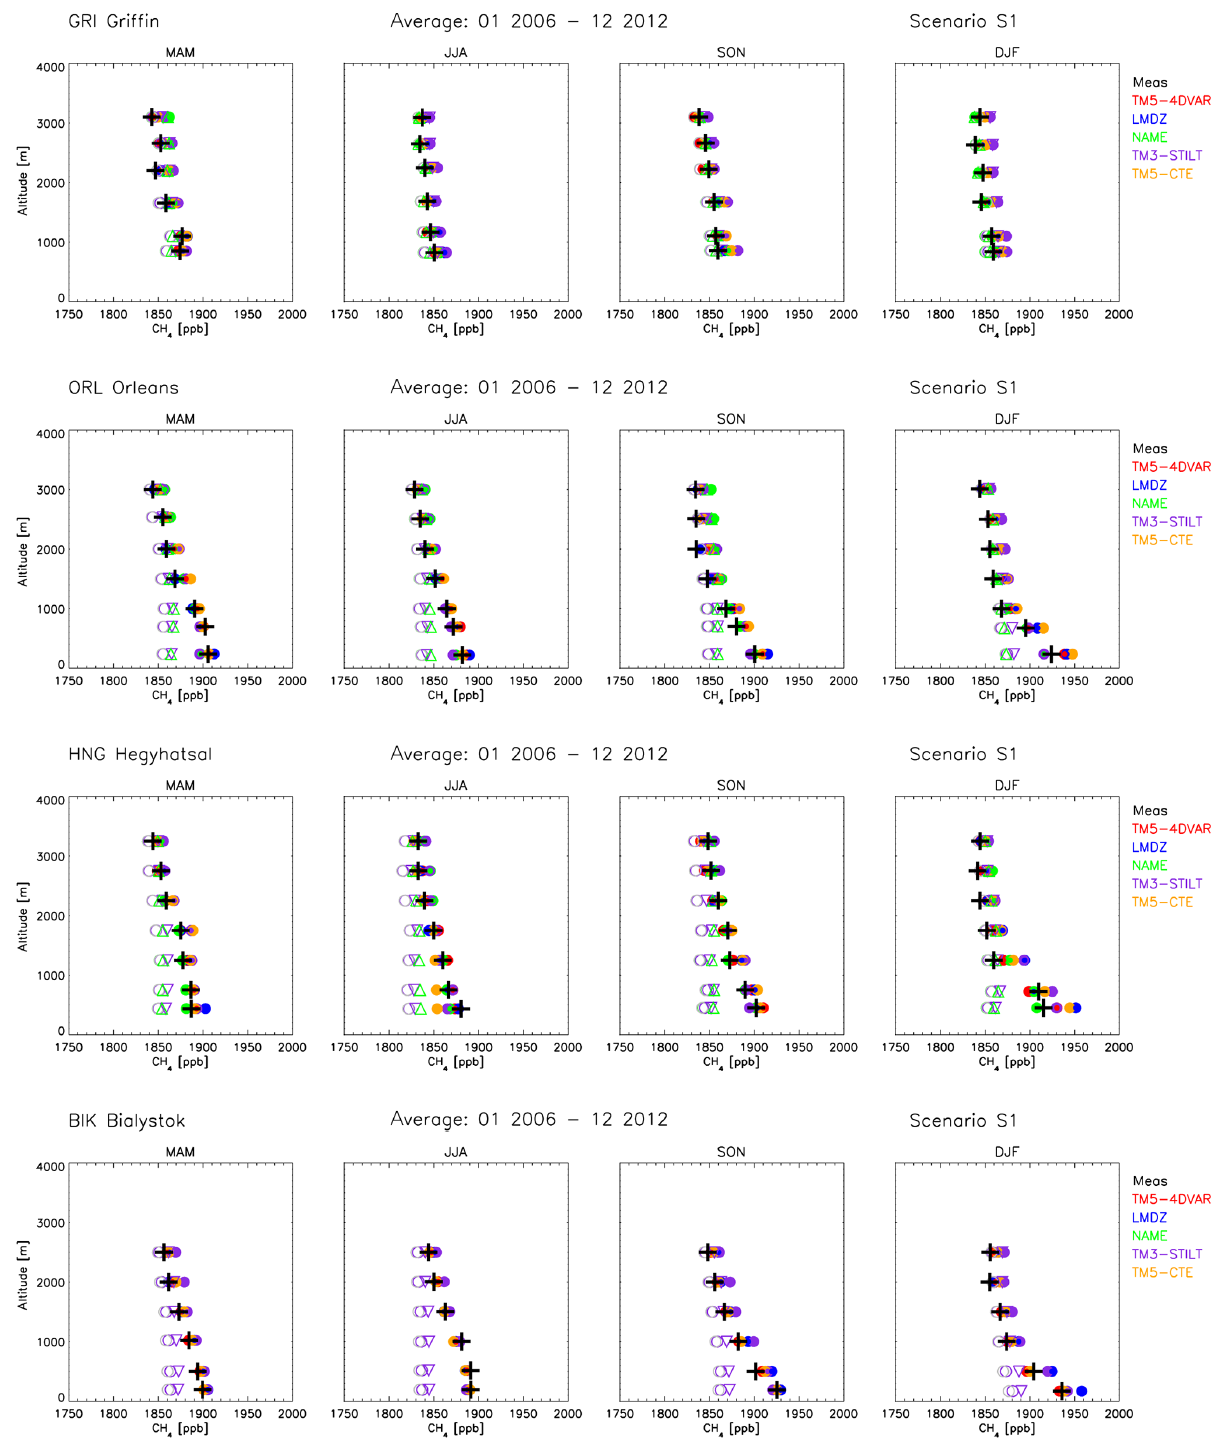
Figure 5. Seasonal averages over all available aircraft profile measurements of CH 4 at Griffin (Scotland), Orléans (France), Hegyhátsál (Hungary), and Białystok (Poland) (black crosses) during 2006–2012 and average of corresponding model simulations (filled coloured symbols). The open circles show the calculated background mole fractions, based on the method of Rödenbeck et al. (2009), calculated with TM5-4DVAR for the TM5-4DVAR zoom domain (grey), and for the NAME (green) and TM3-STILT (violet) domains (the latter are, however, only partially visible, since they largely overlap with the background for the TM5-4DVAR zoom domain). The open upper triangles (green) are the background mole fractions used in NAME (based on baseline observations at Mace Head), and open lower triangles (violet) are the background mole fractions used in TM3-STILT (based on TM3